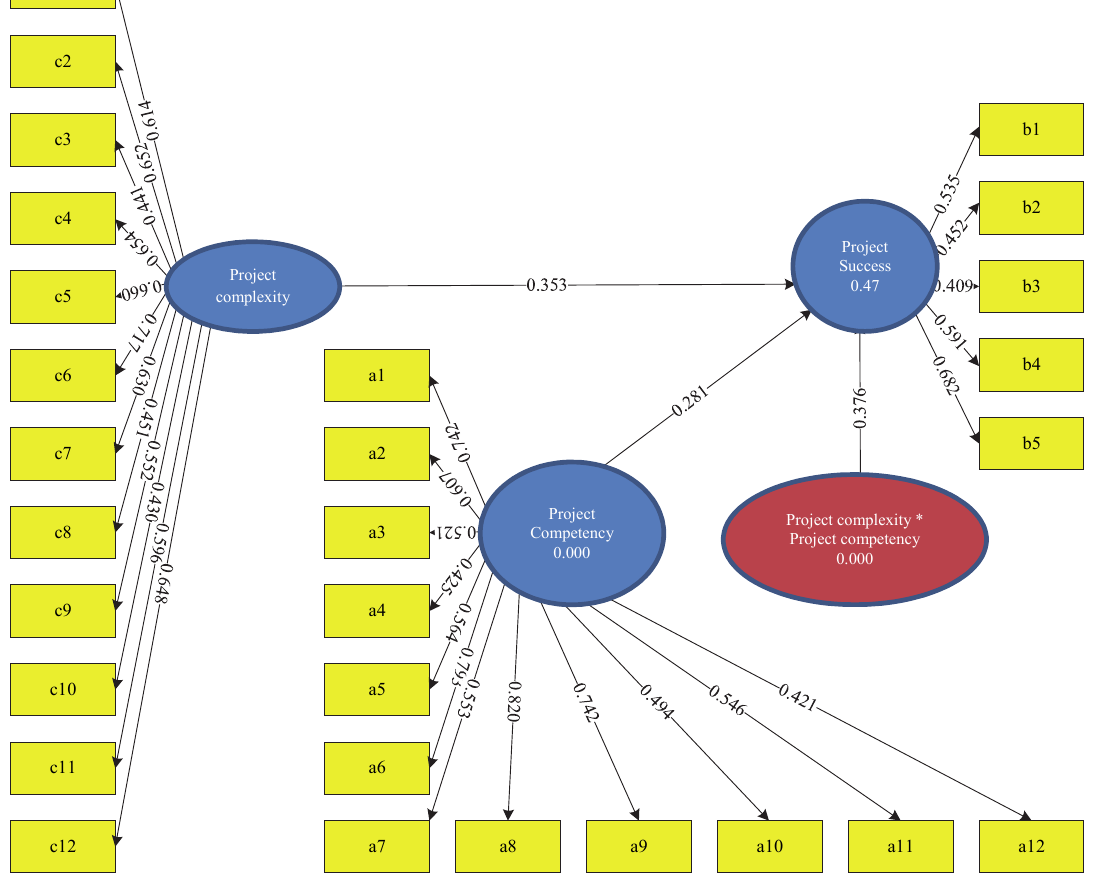
Fig. 1. Executed model with factor load